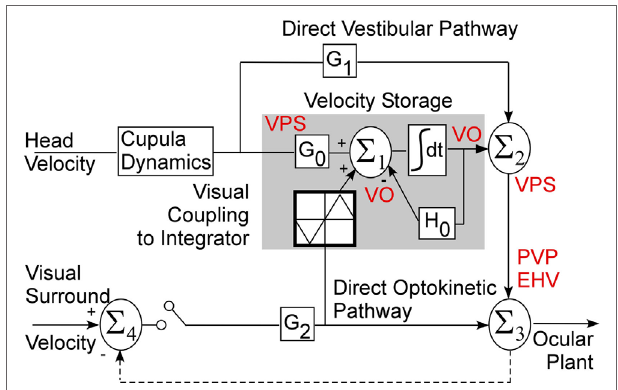
FigUre 1 | Three-dimensional model of velocity storage integrator. G 0 represents vestibular input to the integrator (gray area), G 1 represents direct vestibular, and G 2 direct optokinetic pathways; H 0 represents the leak of the integrator. See text for